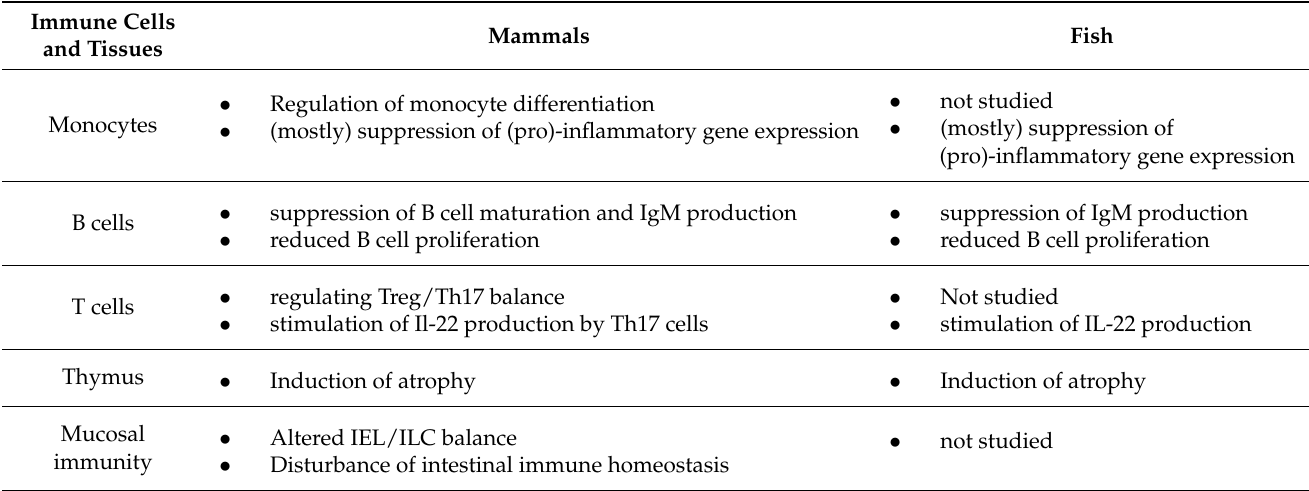
Table 1. Immune parameters (selection) modulated by xenobiotic AhR